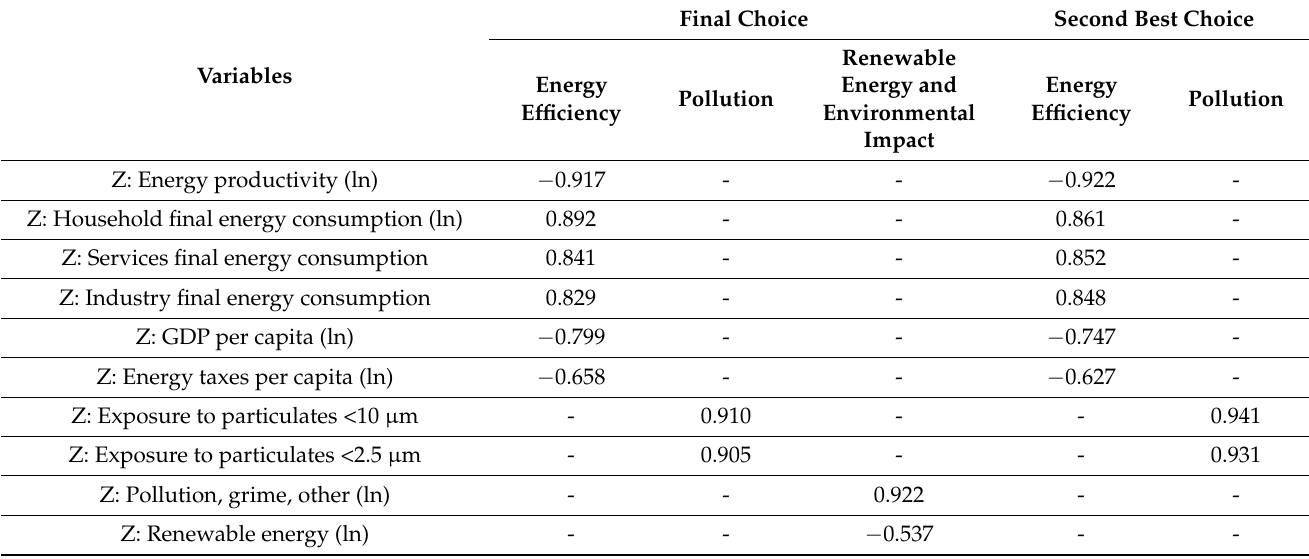
Table 6. Correlations between components and input variables based on PCA